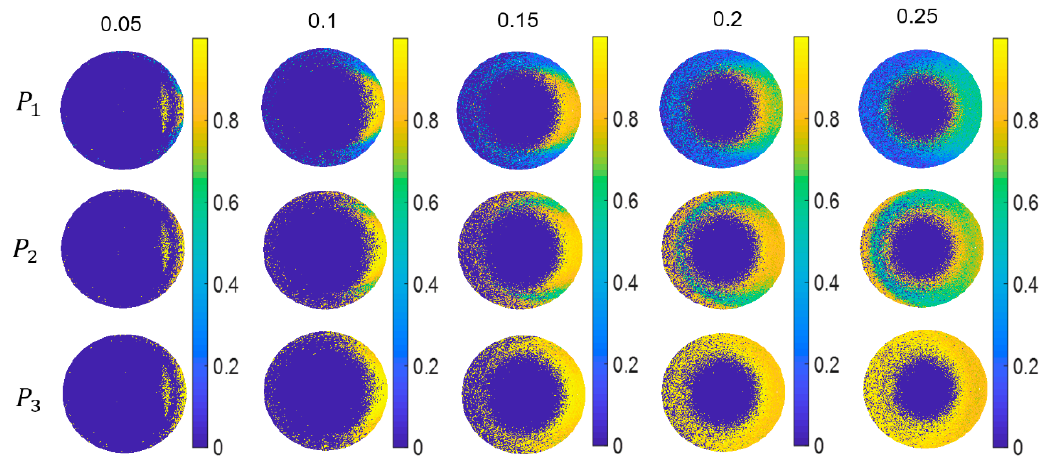
Figure 6. P 1 , P 2 , P 3 of each grid in the upper hemisphere with the changing roughness of Cu targets.